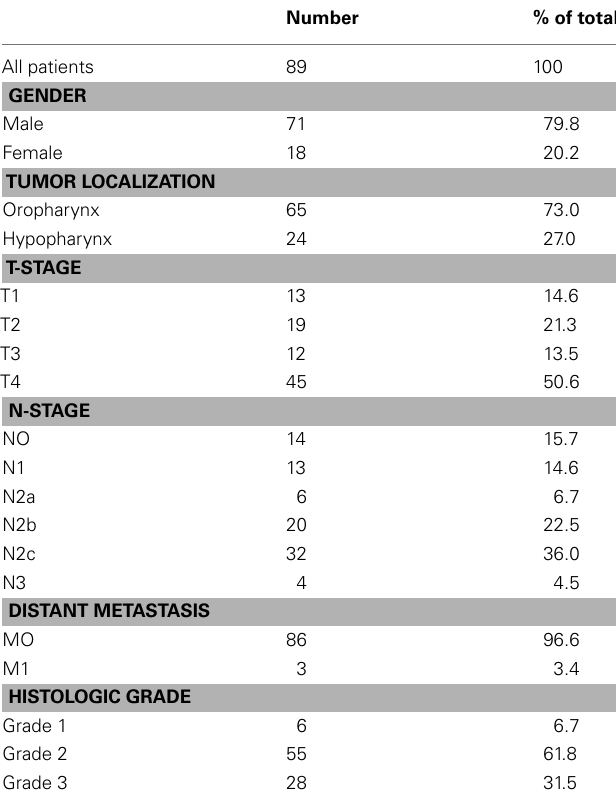
Table 1 | Characteristics of the patients used forTMA analysis and association with clinical parameters (survival,T-stage, and